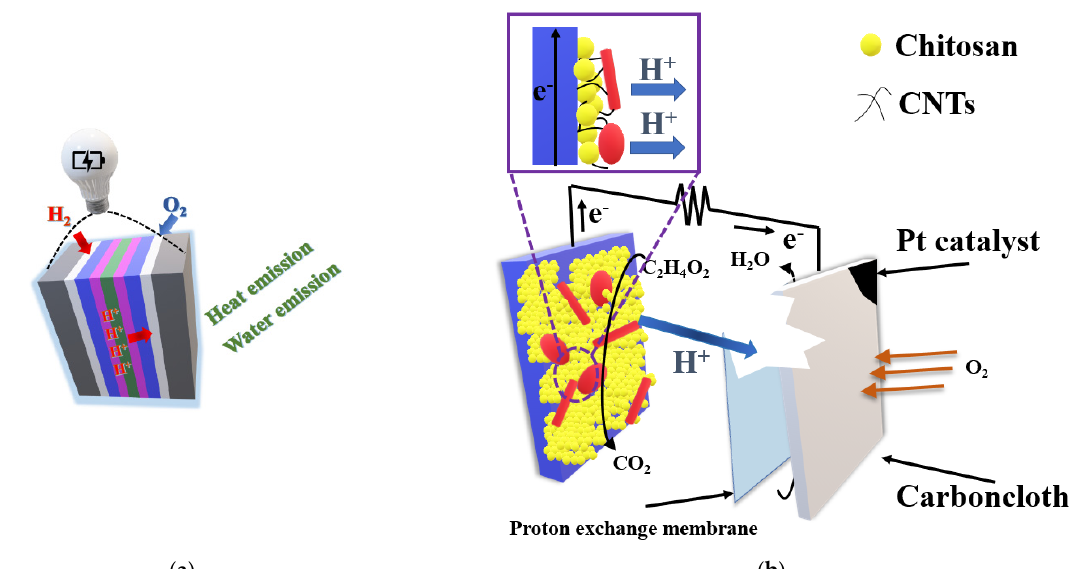
Figure 8. Fuel cell action and structure. The most popular membrane is Proton Exchange Membrane Fuel Cell (PEMFC), which also plays a role of polymer solid electrolyte ( a ); working principles of the microbial fuel cell (MFC) bioanode [157] ( b ).